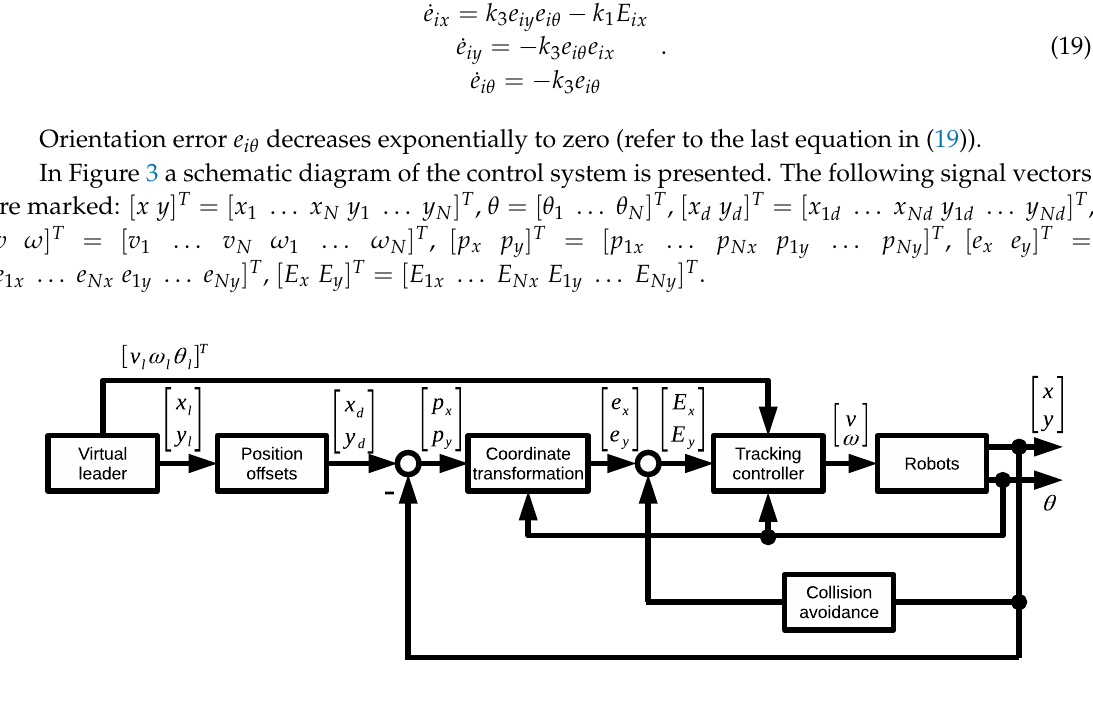
Figure 3. Control